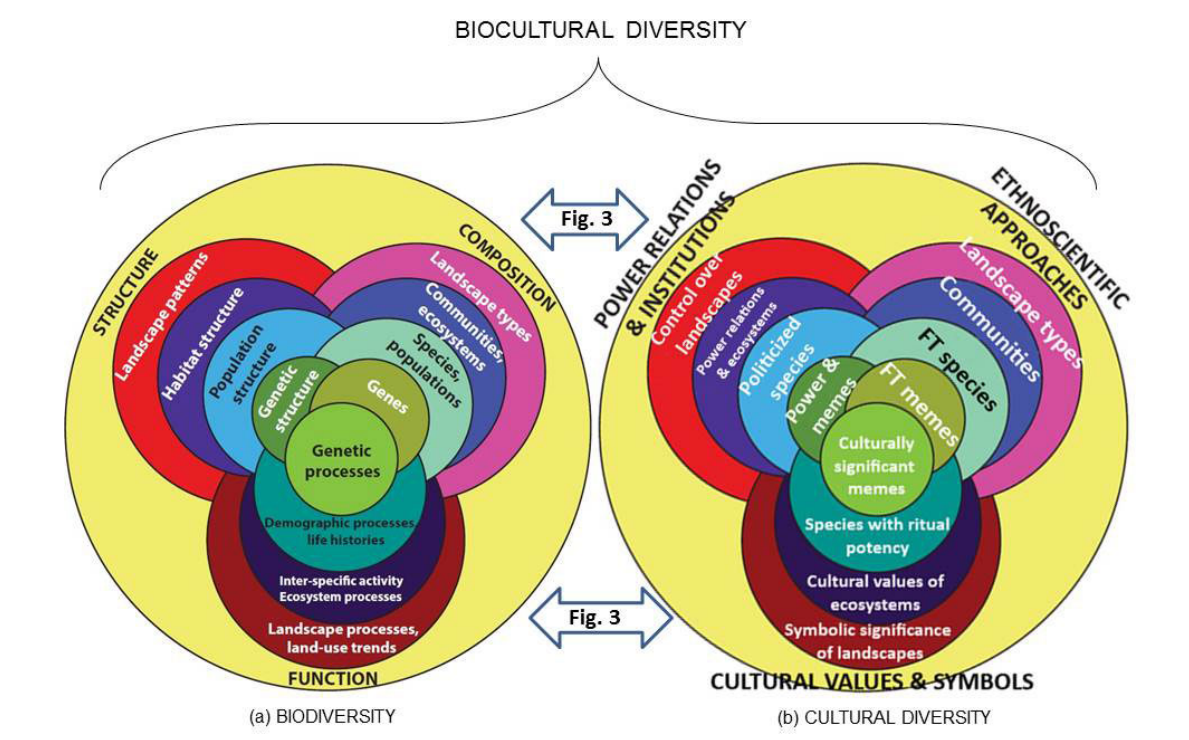
Fig. 2 . A conceptual framework for biocultural diversity, consisting of (a) a biodiversity component (Noss 1990), and (b) a cultural diversity component, indicating cultural values and symbols, ethnoscientific approaches (including folk taxonomy [FT]), and power relations and institutions that influence biocultural diversity as interrelated spheres along four levels of organization. The links between the two spheres are presented in Figure